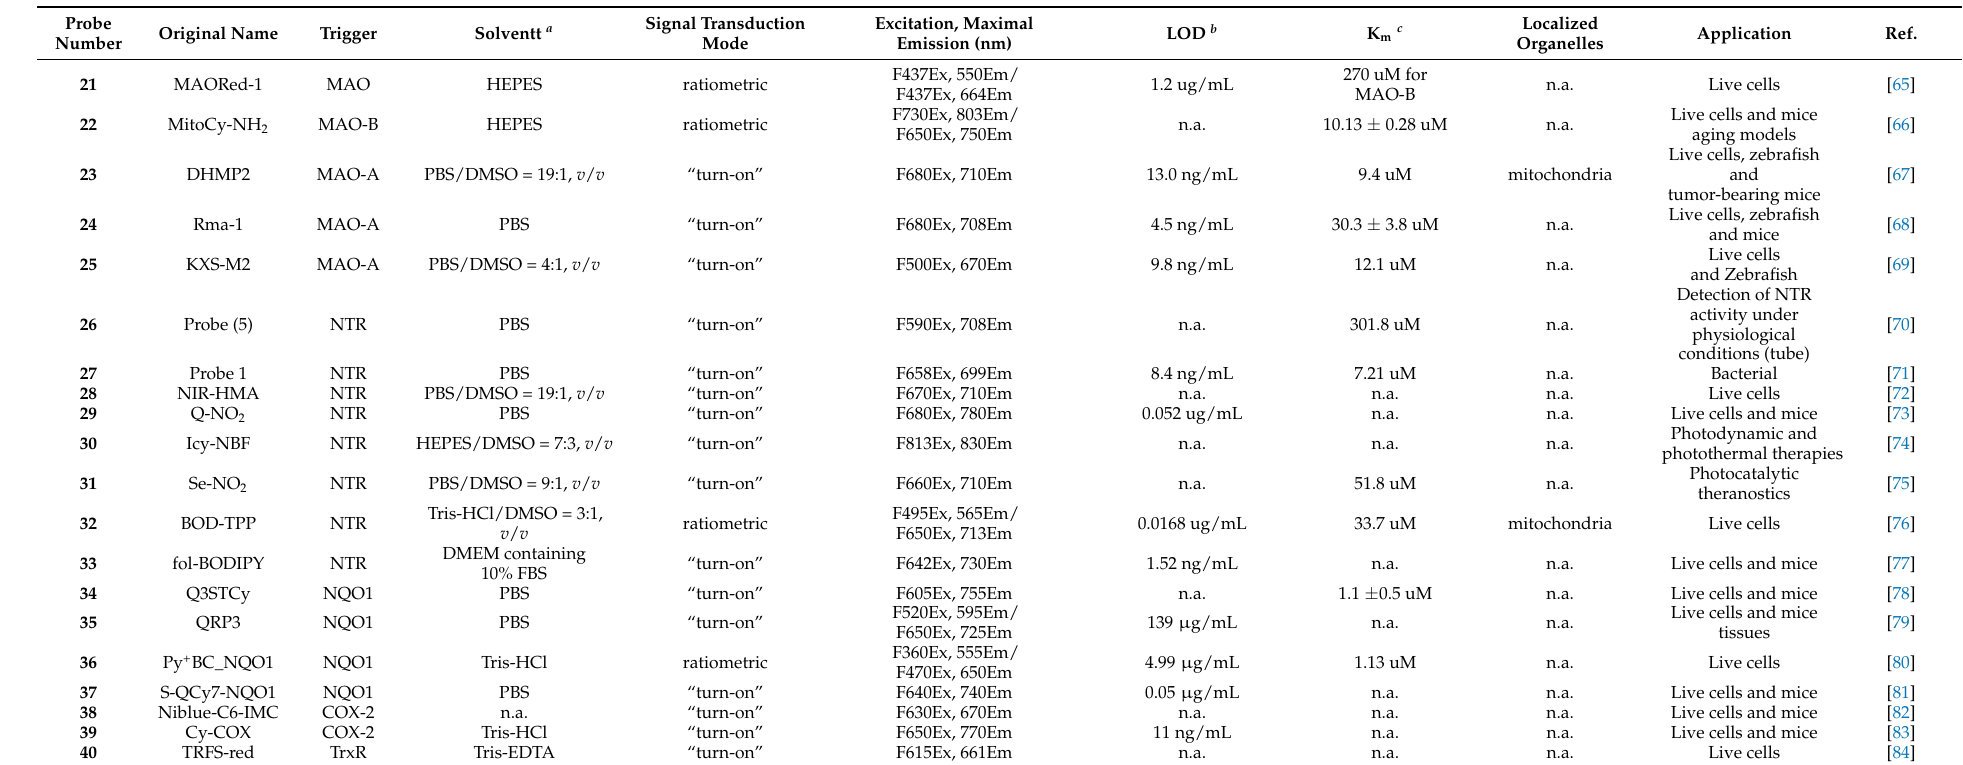
Table 2. Properties of NIR fluorescent Probes 20 − 40